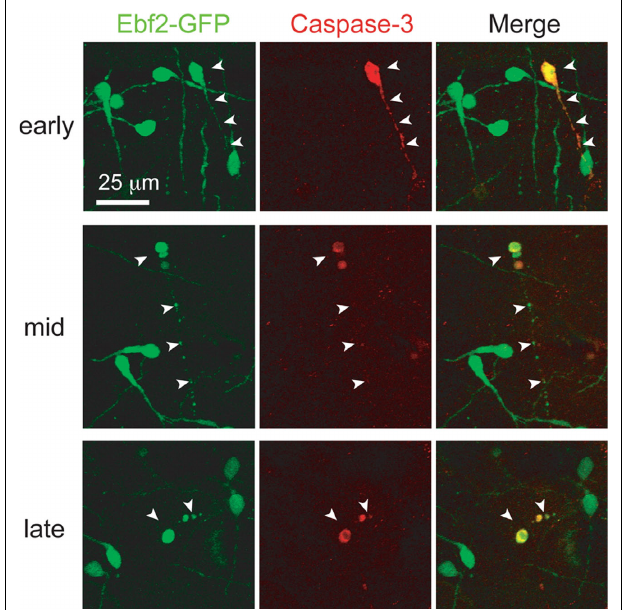
FIGURE 6 | Caspase-3 expression within dying CR neurons. Colocalization between activated caspase-3 (red) and Ebf2-GFP expression in dying CR neurons. Tangential sections through layer 1 of the neocortex of perfusion- fi xed Ebf2-GFP mice at P8-P10 were stained with antibodies against activated caspase-3 and imaged with two-photon microscopy. Note how caspase-3 is expressed in the cytoplasm of dying CR neurons at the earliest stages of degeneration (top row), when CR neurons appear normal and maintain their tadpole morphology, as well as in late stages of cell death (bottom row), when only apoptotic bodies can be identifi ed. Images are maximum intensity projections of 10–12 slices, 3 µm